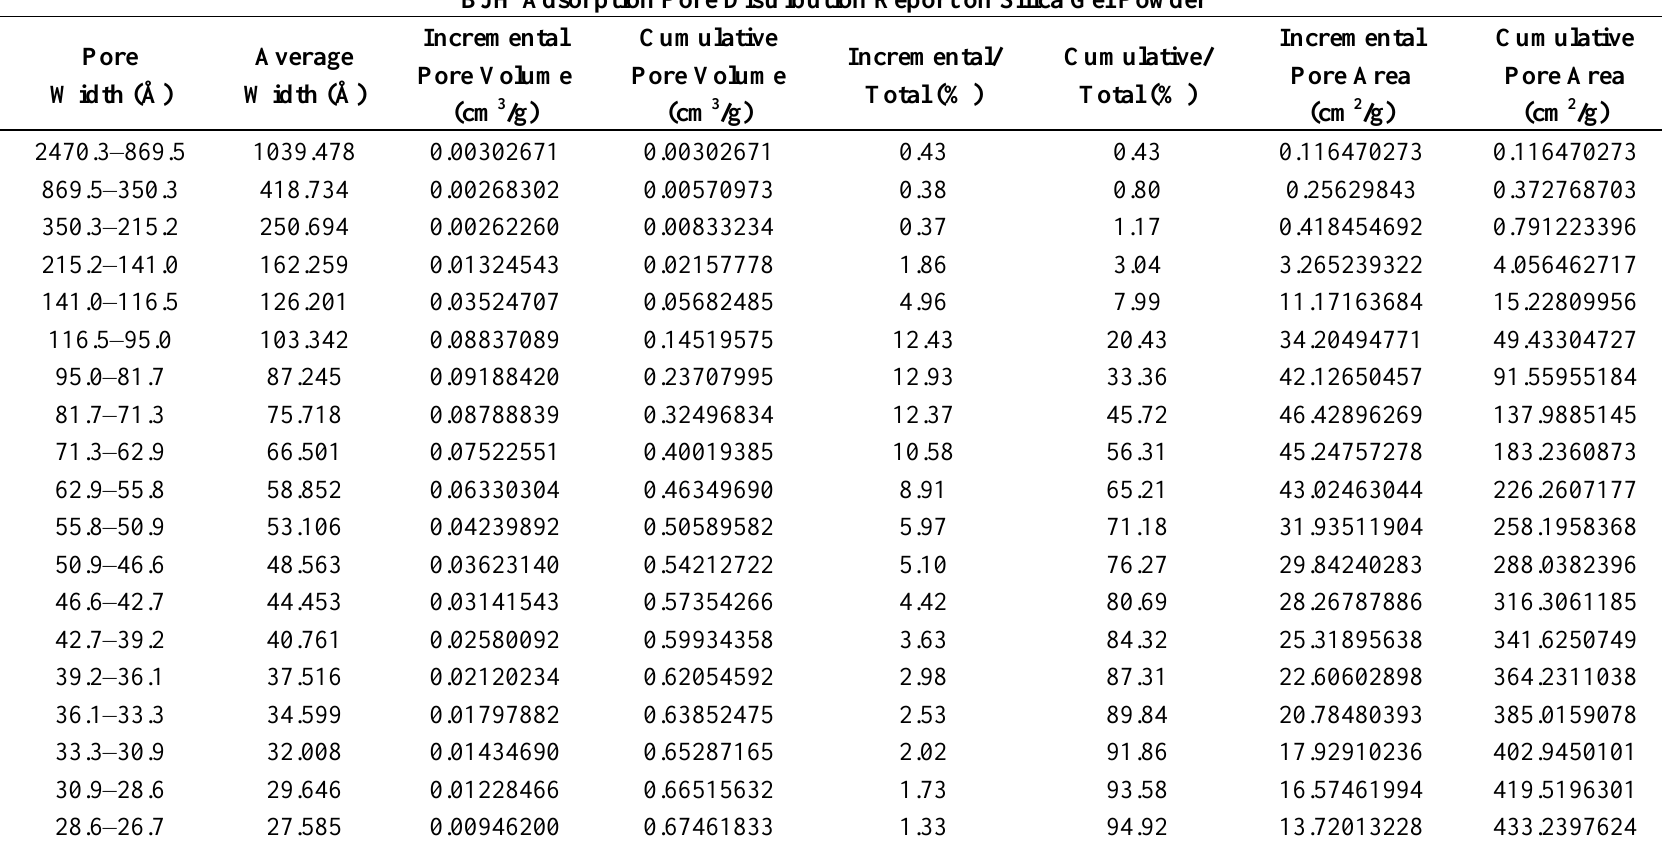
Table 2. Pore distribution characteristics of silica gel